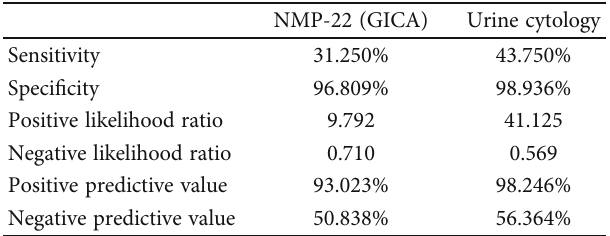
Table 3: Diagnostic e ffi cacy of NMP-22 (GICA) and urine